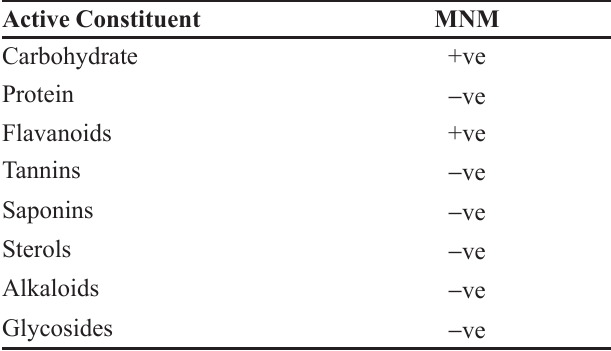
TABLE I - Phytochemical screening of Mulva neglecta